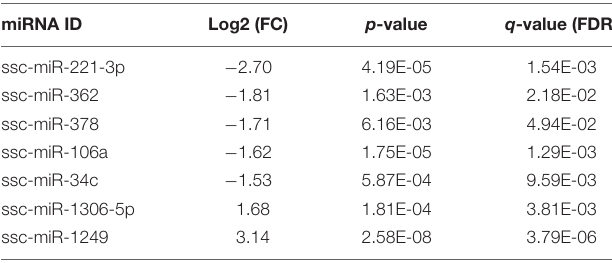
TABLE 4 | List of the miRNAs showing distinct seasonal abundance. miRNA ID Log2 (FC) p -value q -value (FDR) ssc-miR-221-3p − 2.70